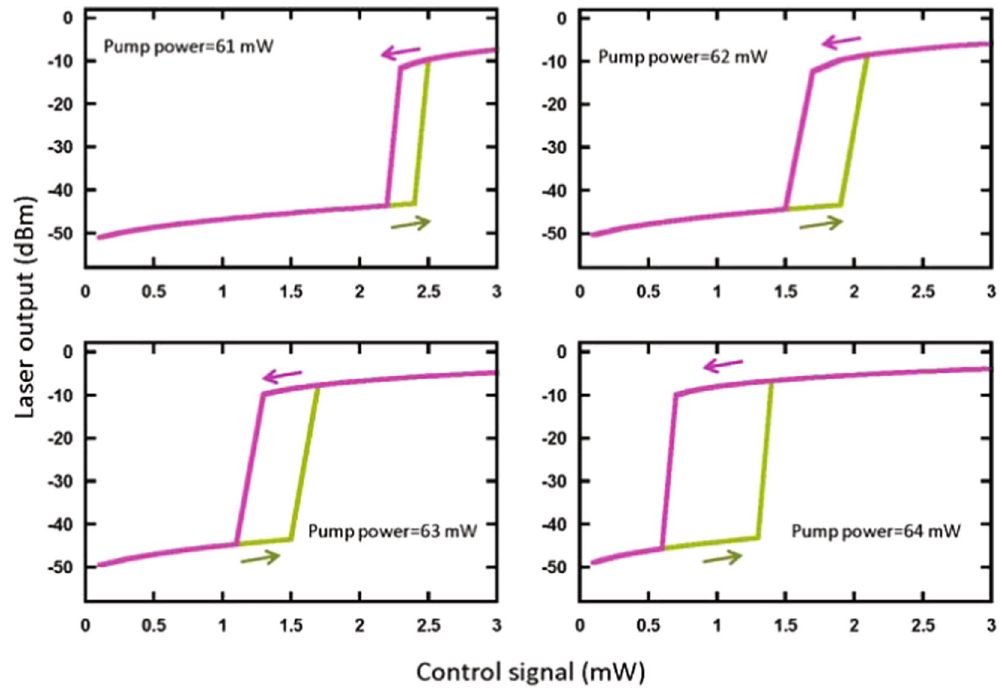
Figure 5. Laser output power versus control signal for different powers of pump